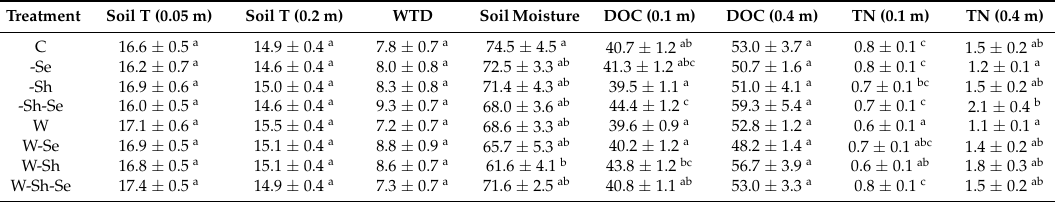
Note: C represents control; W represents warming; -Se represents sedge removal; -Sh represents shrub removal; -Sh-Se represents shrub and sedge removal. The units of soil T, soil moisture, and water table depth (WTD) were ◦ C, %, and m, respectively. The unit of total nitrogen (TN) and dissolved organic carbon (DOC) was mg/L. The number in the brackets represents the depth below the surface. Different lowercase letters represent significant differences ( p < 0.05) between